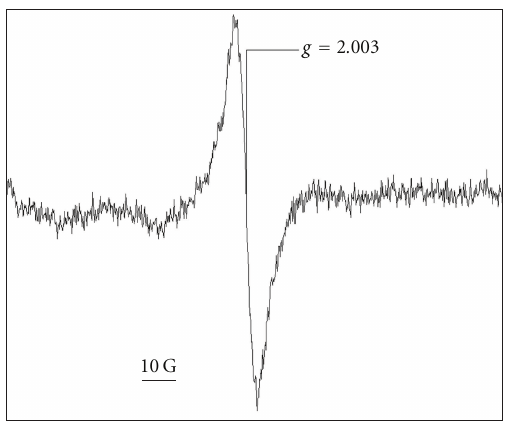
Figure 2: Typical EPR spectrum of melanin. This spectrum was obtained for measurement of 5 µ g of synthetic